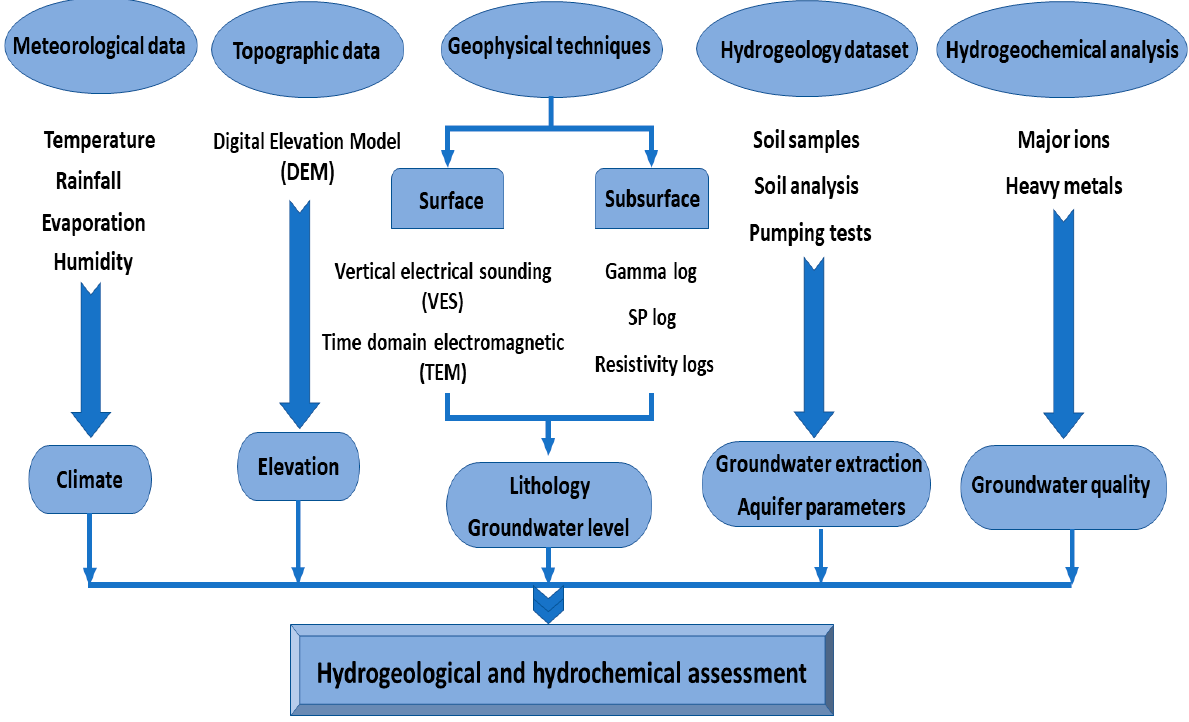
Figure 3. Flow chart of the used methodological steps.